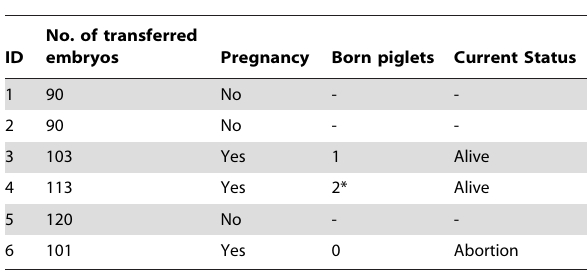
Table 2. Production of cloned hHO-1 transgenic